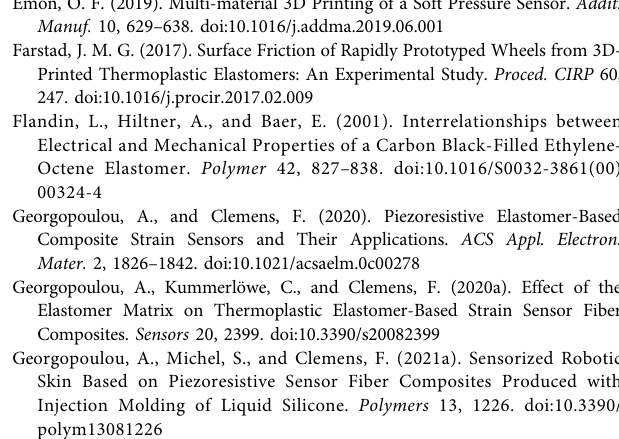
Supplementary Table S1 | Measurements of the length, width, and thickness of the substrates of the strips after printing. The measurements were derived from three different samples. Supplementary Figure S1 | TPU strip with an integrated in situ strain sensor printedusingamulti-materialFDMprinter.TheTPUsubstrate(orange)andthestrain sensing element (black) printed with the Eel fi lament. SupplementaryFigureS2 |Calculationofthe (A) uncertainty, (B) buckling,and (C) signal drift during the dynamic tensile testing. Supplementary Figure S3 | Cross-section of the samples, measured using the optical microscope, for the samples (A) FilaFlex 70A, (B) FilaFlex 82A, (C) NinjaFlex 85A, (D) FiberFlex 40D, (E) FilaFlex 95A, and (F) Yousu 98A. Supplementary Figure S4 | Dynamic tensile testing between the strains 0% and 30% of 3D-printed TPU strips with in situ integrated strain sensing elements; (A) FilaFlex 70A, (B) FilaFlex 82A, (C) FilaFlex 95A, (D) NinjaFlex 85A, (E) FiberFlex40D, and (F) Yousu 98A. Supplementary Figure S5 | Dynamic tensile test between the strains 0% and 100% for TPU strips with integrated strain sensing elements from (A) FilaFlex 70A, (B) FilaFlex 82A, (C) FilaFlex 95A, (D) NinjaFlex 85A, (E) FiberFlex 40D, and (F) Yousu 98A. Supplementary Figure S6 | Dynamic tensile test between the strains 90% and 120% for the TPU strips with integrated strain sensing elements from (A) FilaFlex 82A, (B) FilaFlex 95A, (C) NinjaFlex 85A, and (D) FiberFlex 40D. Supplementary Figure S7 | Stress response during the dynamic tensile test between the strains 0% and 30% with a dwell time of 30 seconds at 0% and 30 seconds at 30% strain for the TPU strips with in situ integrated sensing elements with a substrate; (A) FilaFlex 70A, (B) FilaFlex 82A, (C) FilaFlex 95A, (D) NinjaFlex 85A, (E) FiberFlex 40D, and (F) Yousu